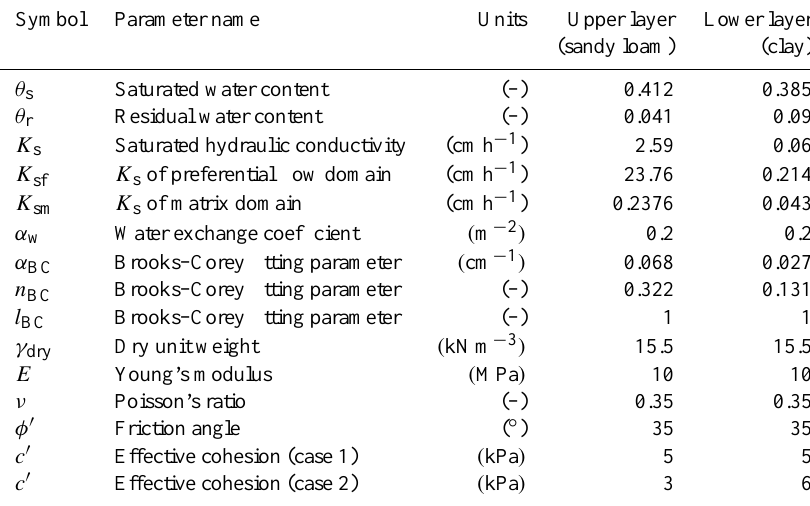
Table 1. Summary of